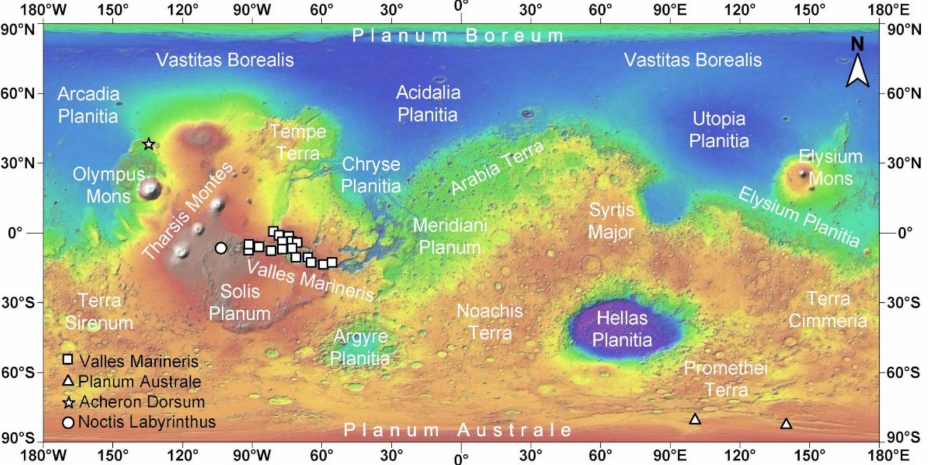
Figure 2. Locations of hypothesized major DSGSDs on Mars based on literature studies, distinct with reference to the four geographical areas described in text (Valles Marineris, Planum Australe, Acheron Dorsum, and Noctis Labyrinthus). Refer to the text for the literature of each area. The Mars image was produced with MOLA colorized